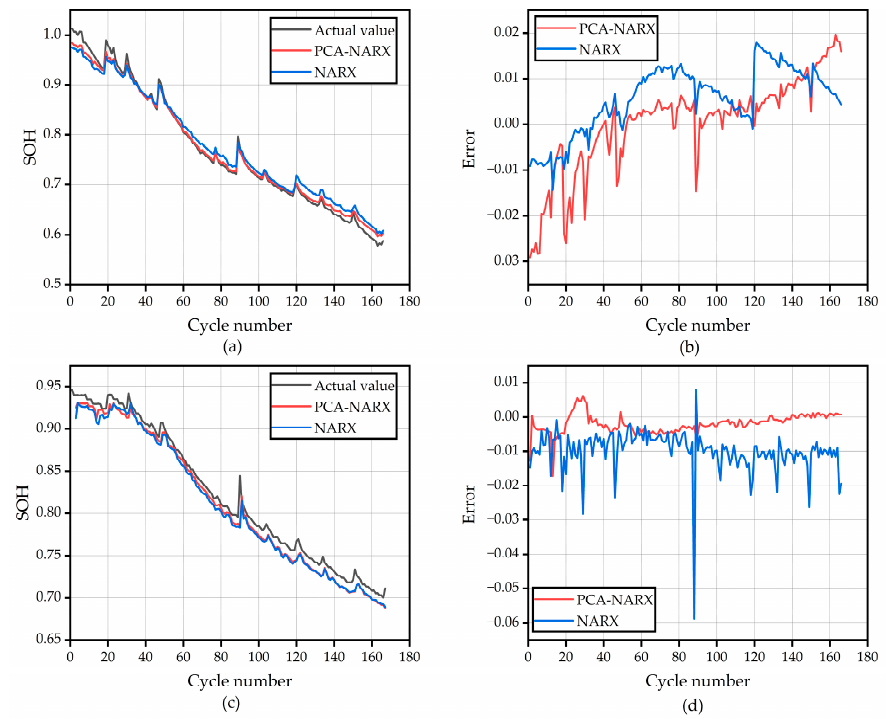
Figure 5. ( a ) SOH estimation curves of B0006 before and after PCA; ( b ) Errors of SOH estimation of B0006 before and after PCA; ( c ) Comparison of SOH estimation curves of B0007 before and after PCA; ( d ) Errors of SOH estimation of B0007 before and after PCA.